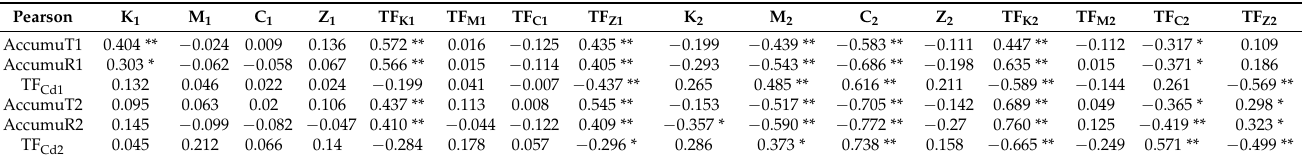
Table 2. The relationships between Cd accumulation and translocation, and nutrient accumulation and allocation.